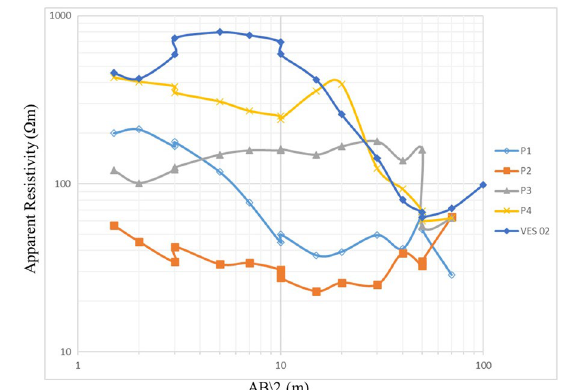
Fig. 12 Apparent resistivity curves of the four VES points (P1, P2, P3, and P4) versus the apparent resistivity curve of survey location VES 02. (Note that VES 02 curve is much smoother and follows a certain trend oppose to curves at survey points P1, P2, P3, and P4 with a highly disturbed